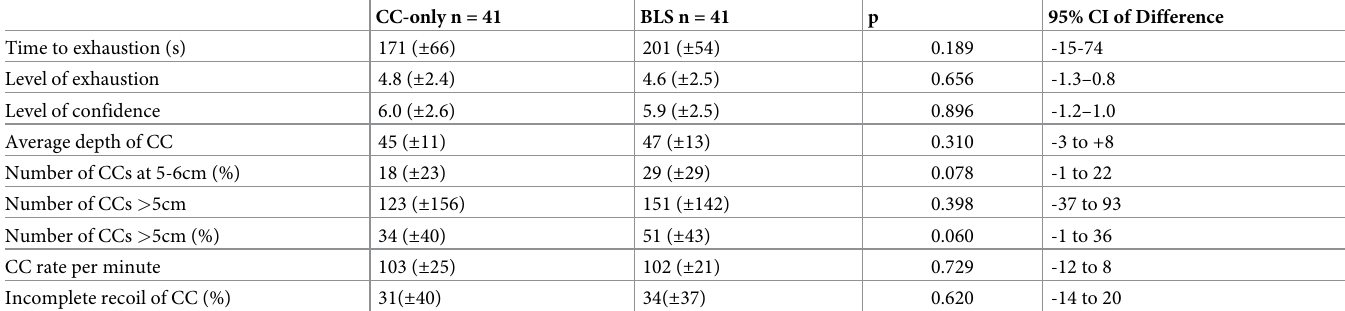
Table 2. Outcome Data; means ( ± SDs) or absolute number (%); 95% CI of